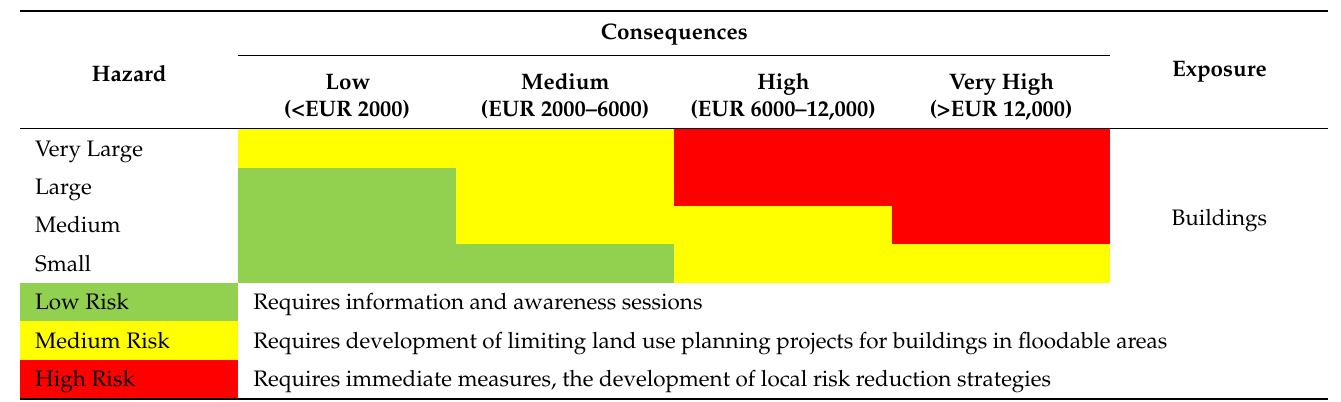
Figure 9. Hazard and risk map for study area. Table 3. Hazard-based risk